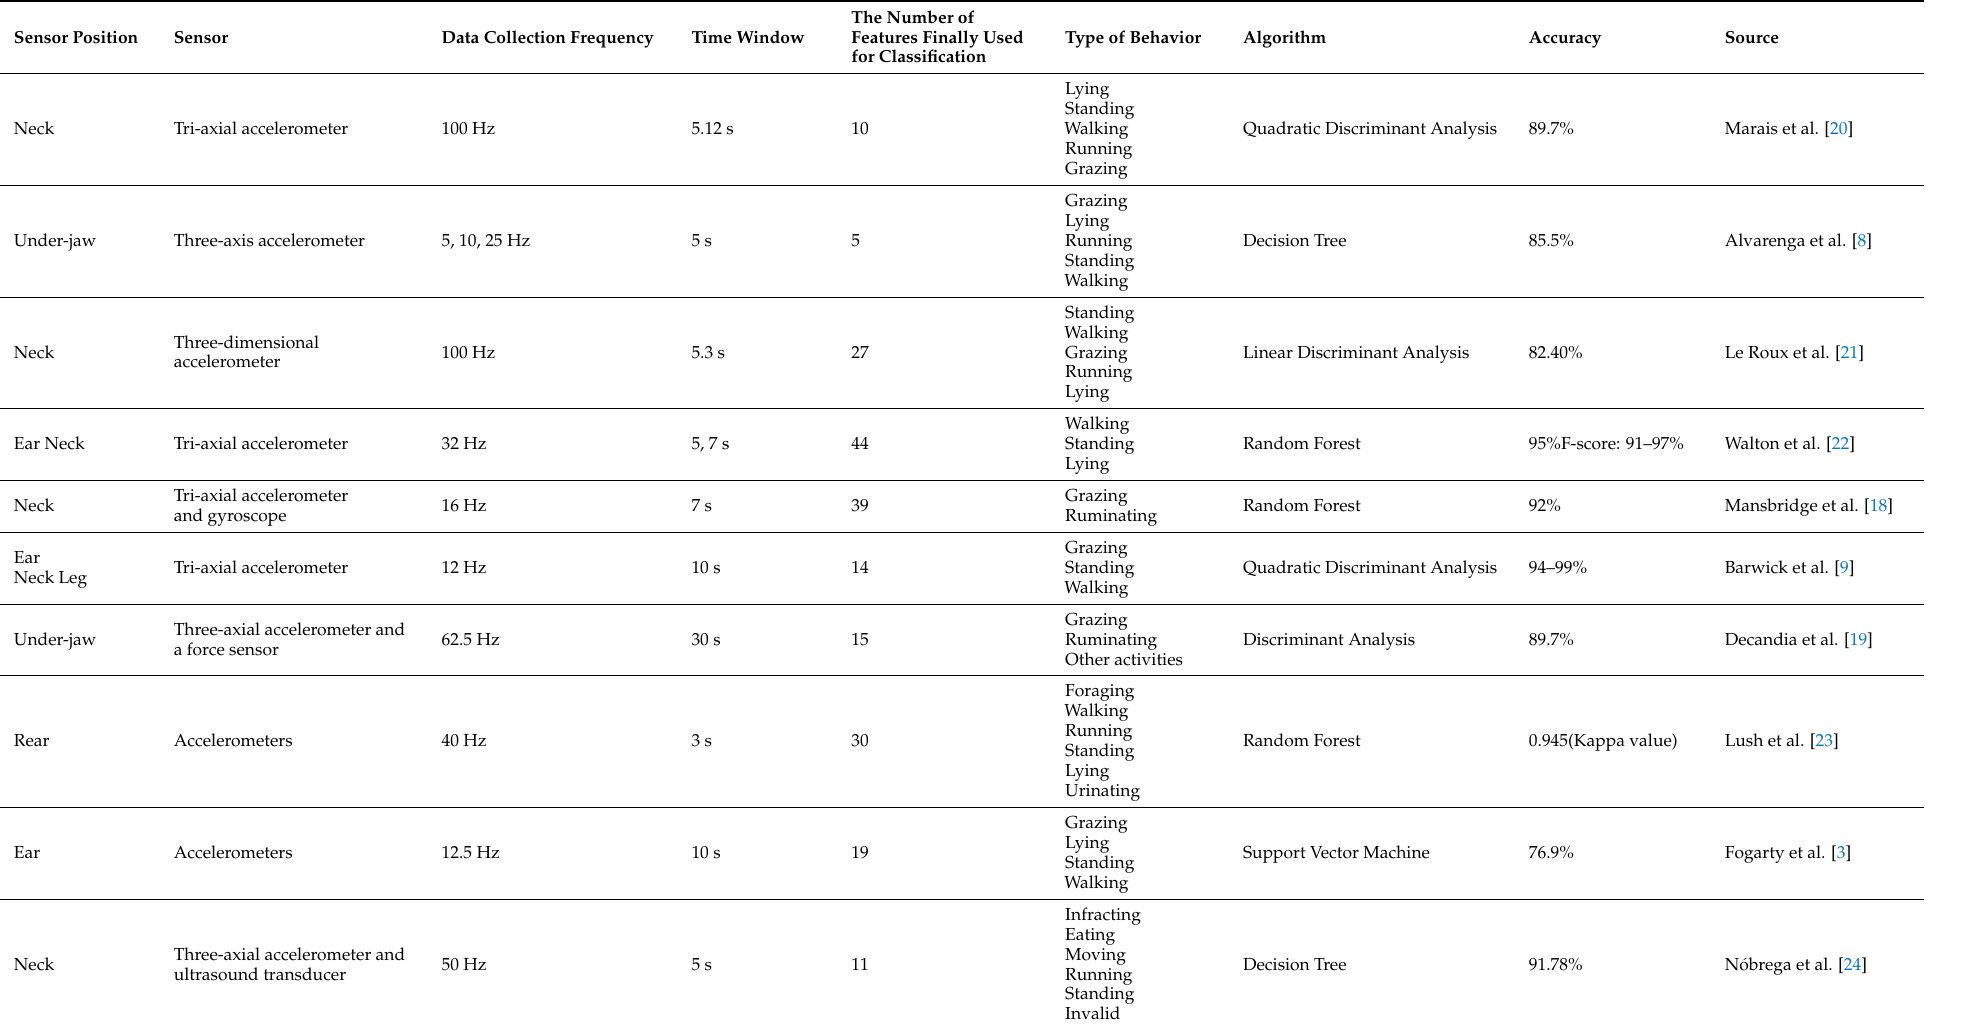
Table 1. Overview of algorithms and other parameters for sheep behavior classification to achieve the best classification